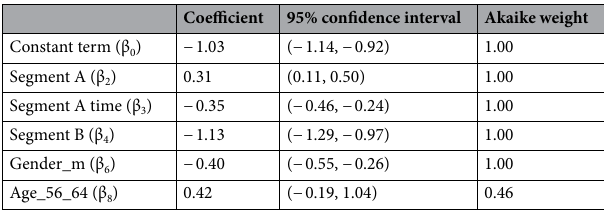
Table 4. The coefficients of the MMI model.